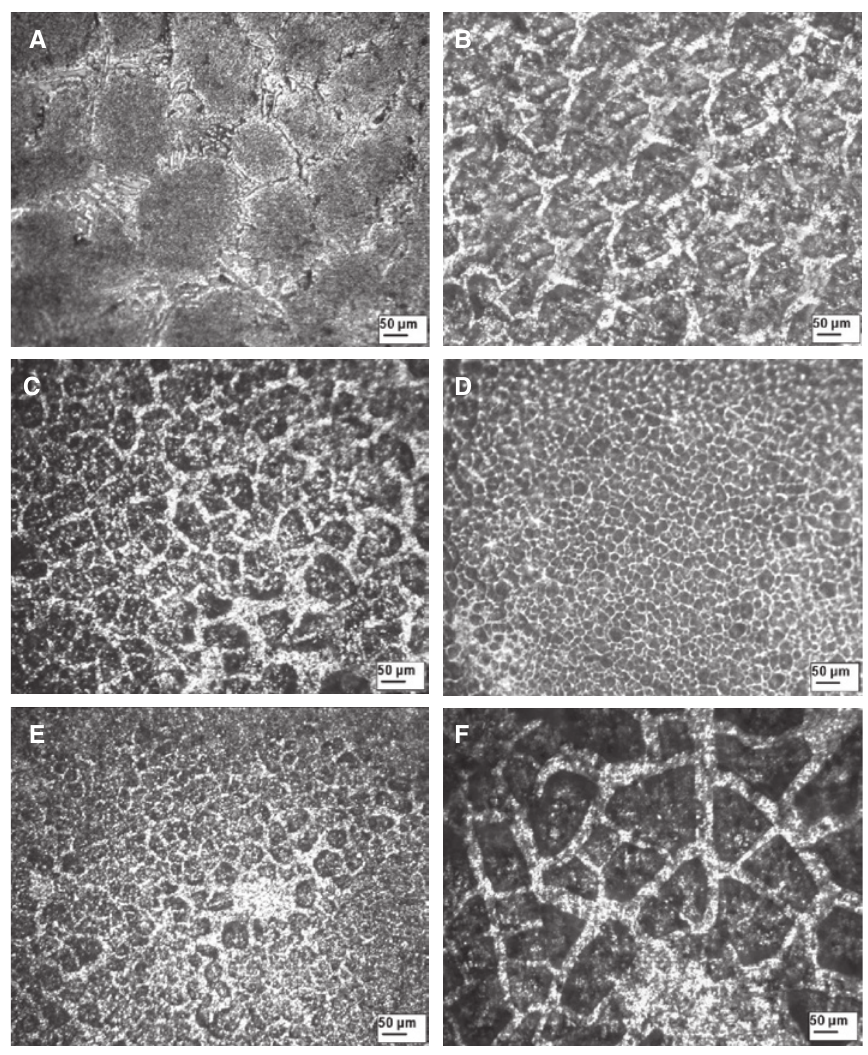
Figure 2: Effect of TVR on FSP region microstructure